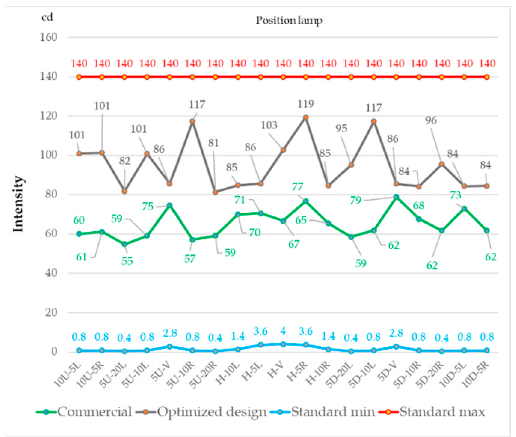
Figure 10. The comparison of simulated optical intensity for the considered angles of EU ECE regulation